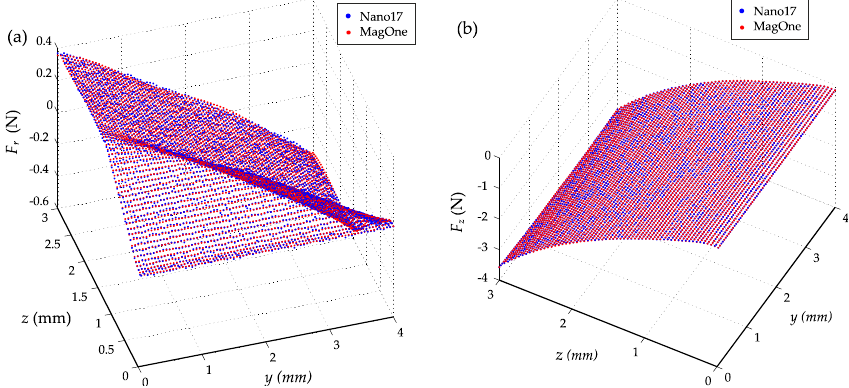
Figure 11. Comparison of the calibrated force output (red circle) from MagOne and the reference force from the F/T sensor (blue circle) during the y - z 2D scanning process: ( a ) Shear force F r in the z - y plane; ( b ) Normal force F z in the z - y plane.